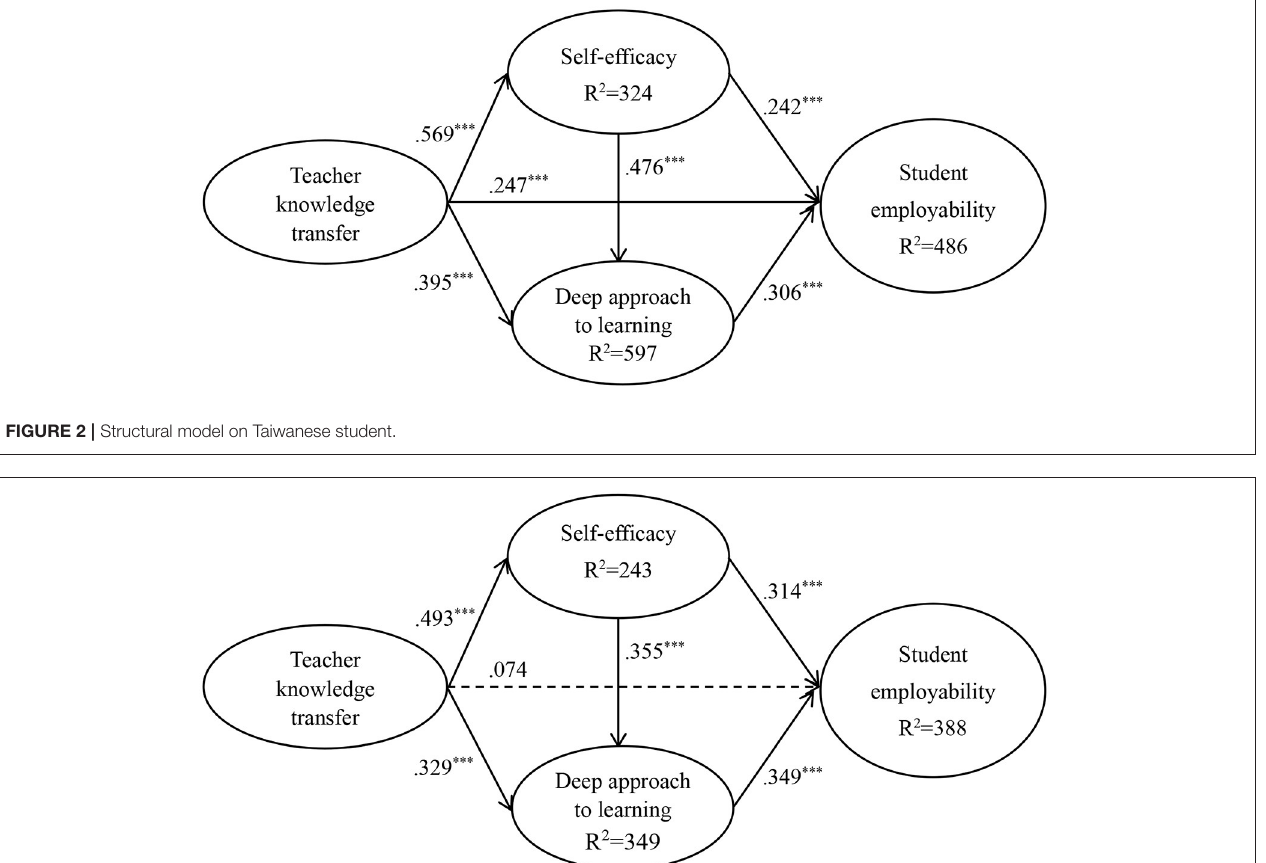
FIGURE 3 | Structural model on Malaysian